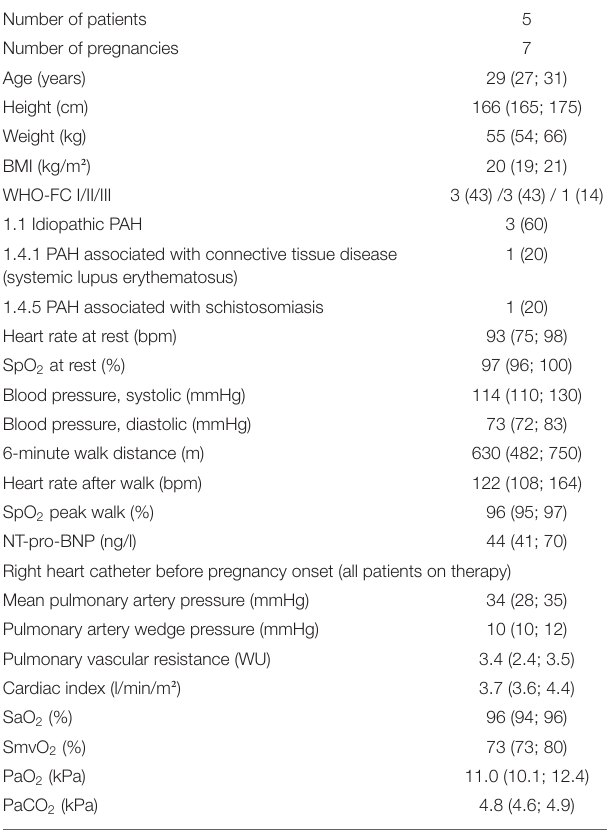
TABLE 1 | Baseline characteristics before pregnancy